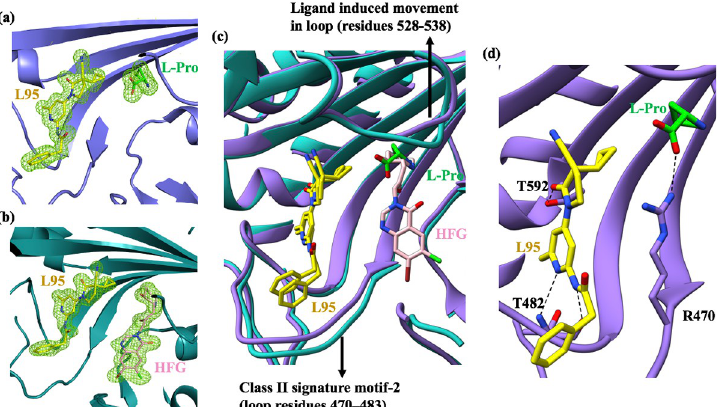
Fig 2. Crystal Structure summary of HFG and L95 bound to Tg PRS. (a and b) Difference Fourier map (Fo-Fc) of the bound ligands in the aminoacylation site of Tg PRS. The Fo-Fc maps are contoured at 3 σ and shown as green mesh representations. Ligands L-pro (green) L95 (yellow), HFG (pink) are shown as sticks. (c) Superposition of Tg PRS-L- pro-L95 and Tg PRS-HFG-L95 complexes showing the ligand induced movement of loops. (d) The interactions between Tg PRS and bound L-pro-L95. The salt bridge interaction with L-pro and interacting residues with L95 are shown as sticks. The hydrogen bonds are shown as black dashed lines.